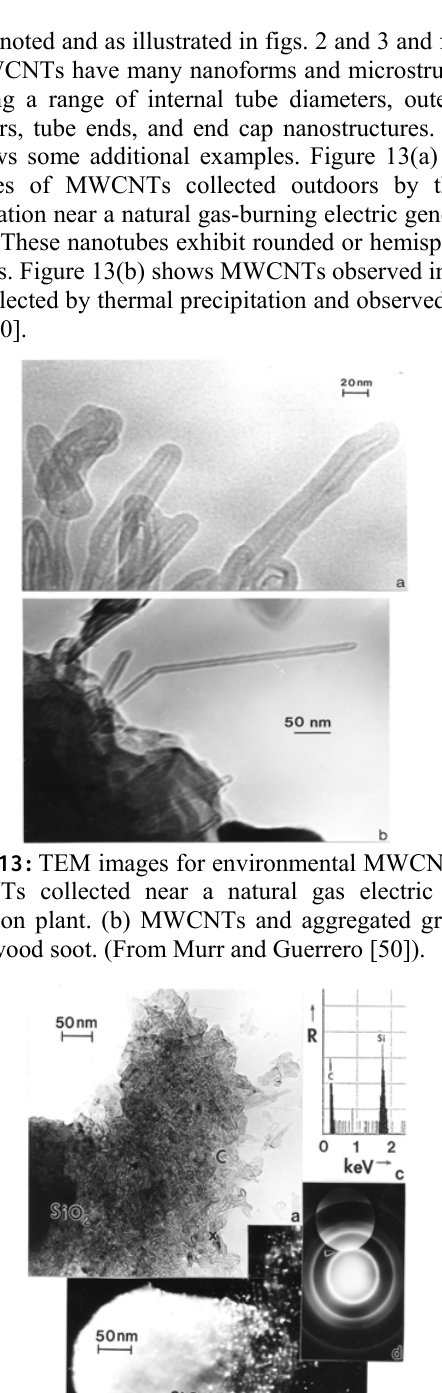
Figure 14: Complex aggregate composed of silica (SiO nano-PM and relatively short MWCNTs and other multiconcentric fullerenes observed in the analytical TEM. (a) Bright-field image. (b) Aperture dark-field image of (a) using the diffraction region marked by arrow in SAED pattern insert in (d). (c) Shows the corresponding EDS spectrum absent the oxygen signal. (From Murr, et al [47]).